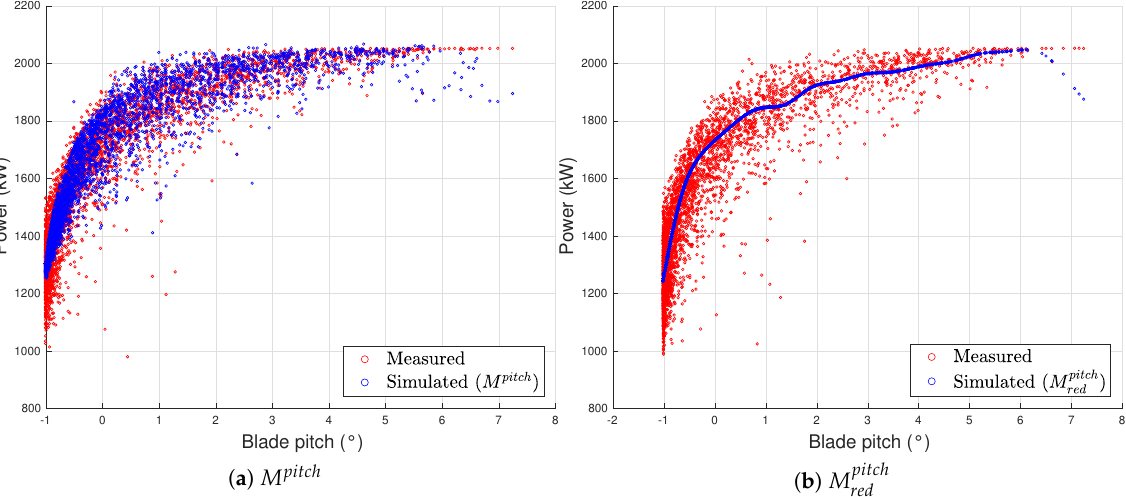
Figure 11. Measured and simulated blade pitch-power curves: D2 data set, T1 wind turbine. M pitch model on the left, M pitch on the red